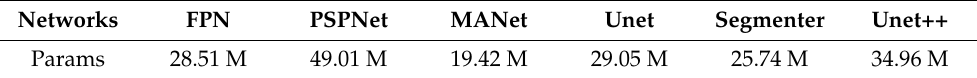
Table 8. Computational complexities of segmentation networks. Networks FPN